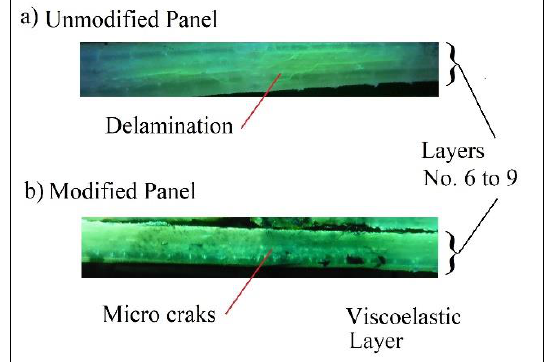
Figure 27. Comparison of the impact section for weight drop at 40 J characterized with fluorescent penetrating inks for unmodified panels ( a ) and modified panels ( b ).